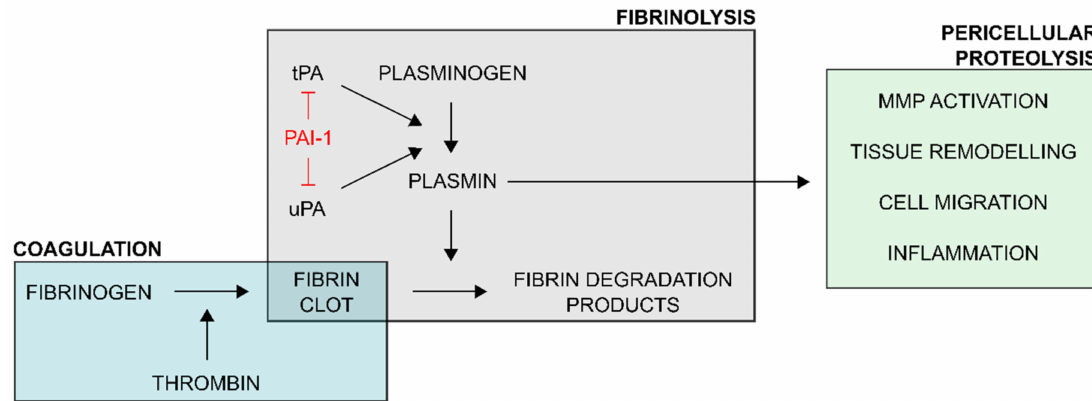
Figure 1. Schematic overview of the regulatory role of plasminogen activator inhibitor-1 (PAI-1) in the plasminogen activator/plasmin system. Upon vascular injury, the coagulation process ultimately generates thrombin which acts upon fibrinogen to form an insoluble fibrin clot. This coagulatory response is balanced by the fibrinolytic system. Plasminogen activators (PAs) tissue-type PA (tPA) and urokinase-type PA (uPA) convert plasminogen to proteolytically active plasmin. Plasmin, the key enzyme of the fibrinolytic system, degrades the fibrin clot into soluble fibrin degradation products. Through uPA-mediated plasminogen activation, the function of plasmin extends to pericellular proteolytic processes, involving activation of matrix metalloproteinases (MMPs), tissue remodeling, cell migration and adhesion, and inflammation. PAI-1 is an important regulator of the plasminogen activator/plasmin system as it interferes with plasminogen activation by directly inhibiting tPA and